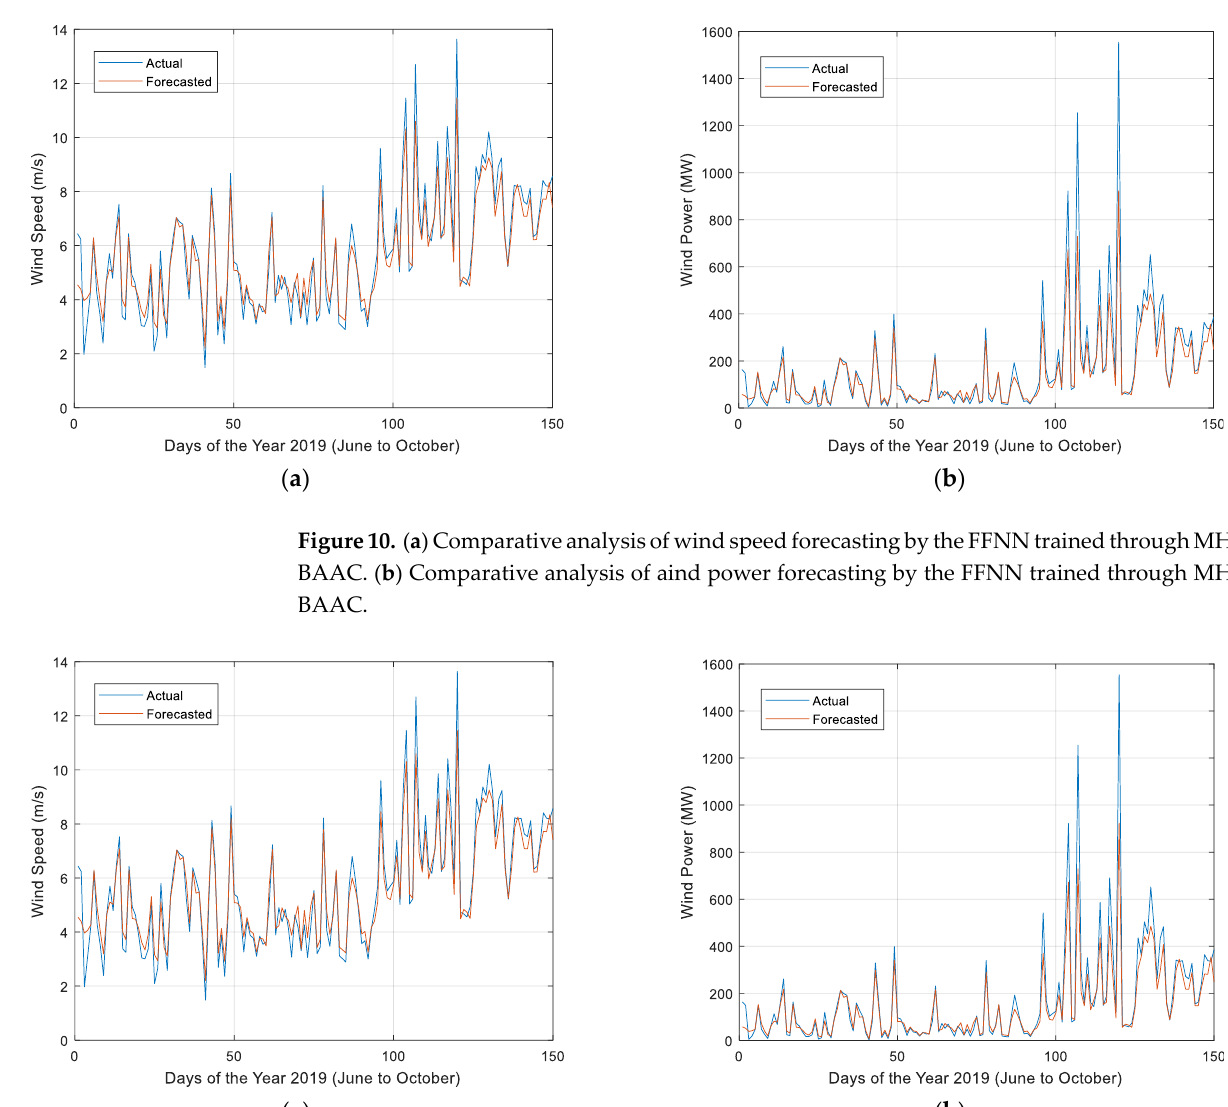
Figure 9. ( a ) Comparative analysis of wind speed forecasting by the FFNN trained through HPSOBA. ( b ) Comparative analysis of wind power forecasting by the FFNN trained through HPSOBA.